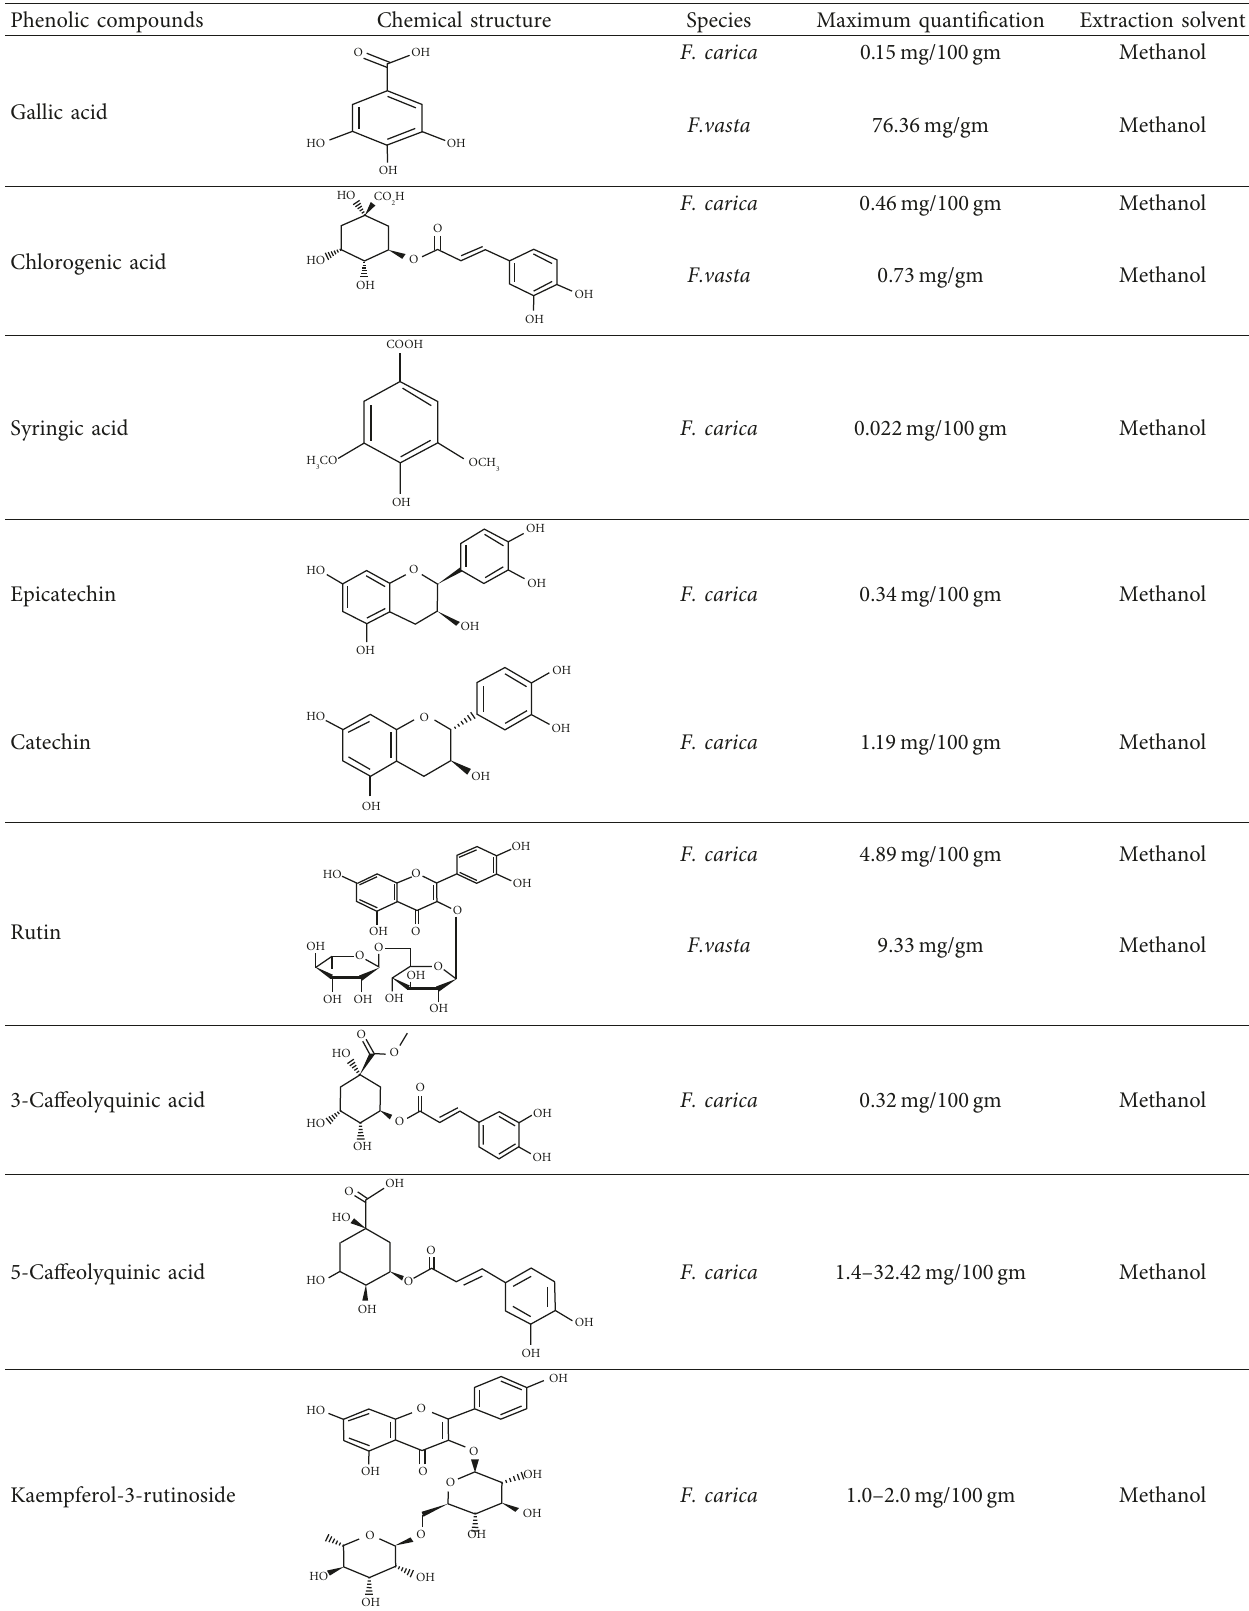
Table 3: Phenolic compounds present in the species used as both fresh fruit and species belonging to genus Ficus . Phenolic